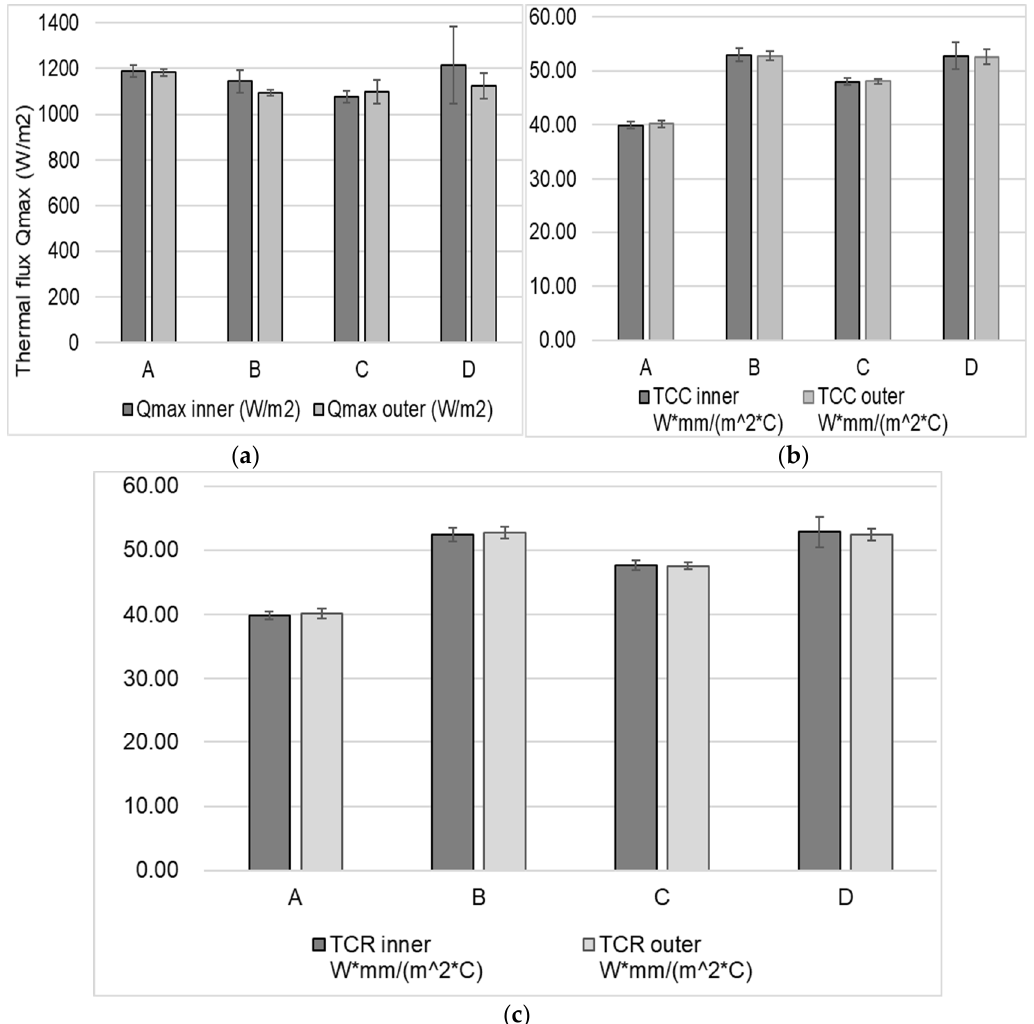
Figure 5. Thermal flux Qmax ( a ), and thermal conductivity during compression TCC ( b ) and recovery TCR ( c ) for the inner and outer side of the fabrics.